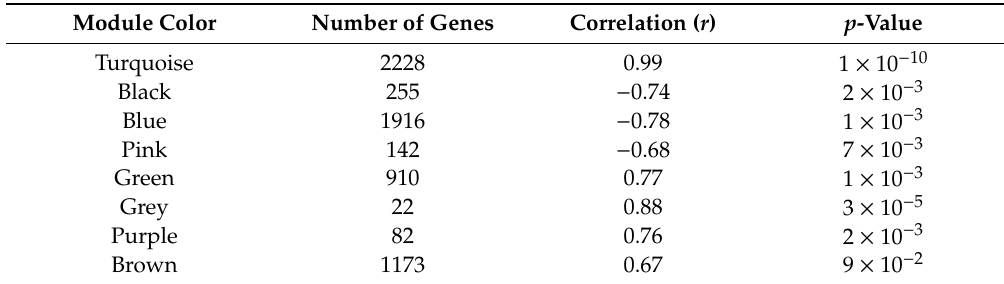
Table 1. Significant co-expression modules in channel catfish